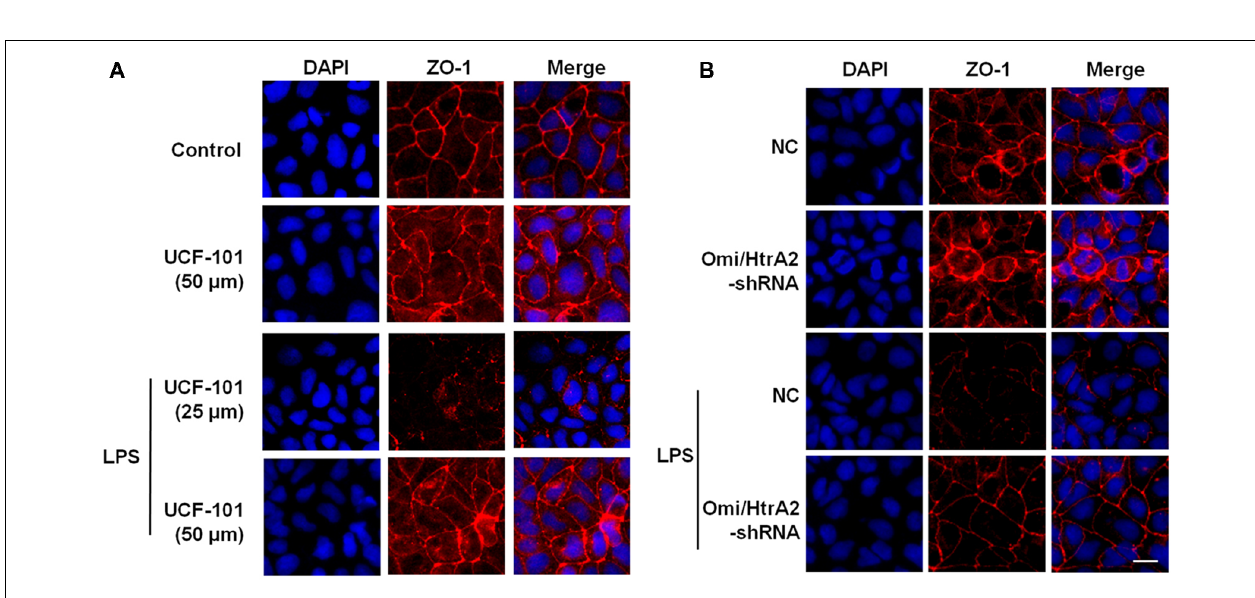
junctional discontinuity and ZO-1 expression level decline in contrast with the control group. Treatment with UCF-101 or Omi/HtrA2 knock-down improved LPS-induced occludin and claudin-5 junction dis-integrity and ZO-1 expression inhibition. We further examined the BBB ultrastructures using TEM ( Figure 3F ). The TJs remained intact in NC-shRNA group and were unclear in NC-shRNA + LPS group. However, the TJ ultrastructure was significantly improved in Omi/HtrA2-shRNA + LPS